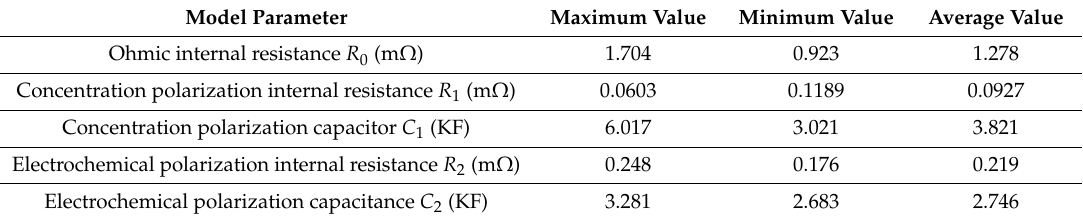
Table 1. Online identification result based on the Bayesian identification